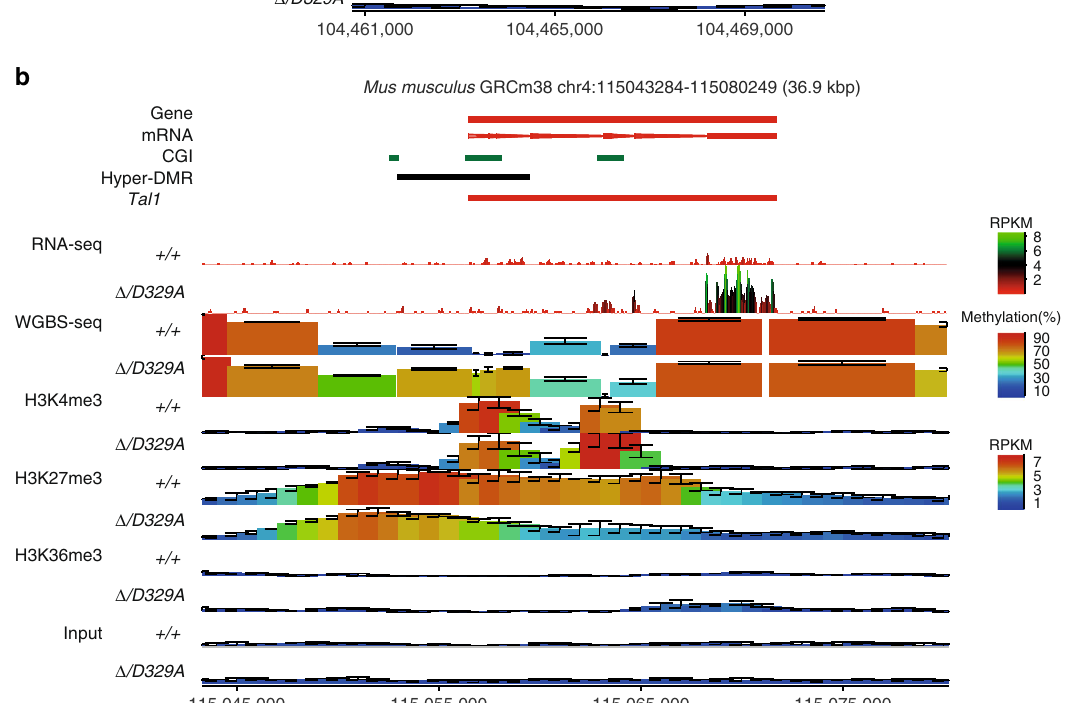
regulation of bivalent chromatin domains and the role of the DNMT3A PWWP domain. This model will be valuable for future investigations into the role of DNA methylation abnormalities in cancer and the growth regulatory function of DNMT3A.